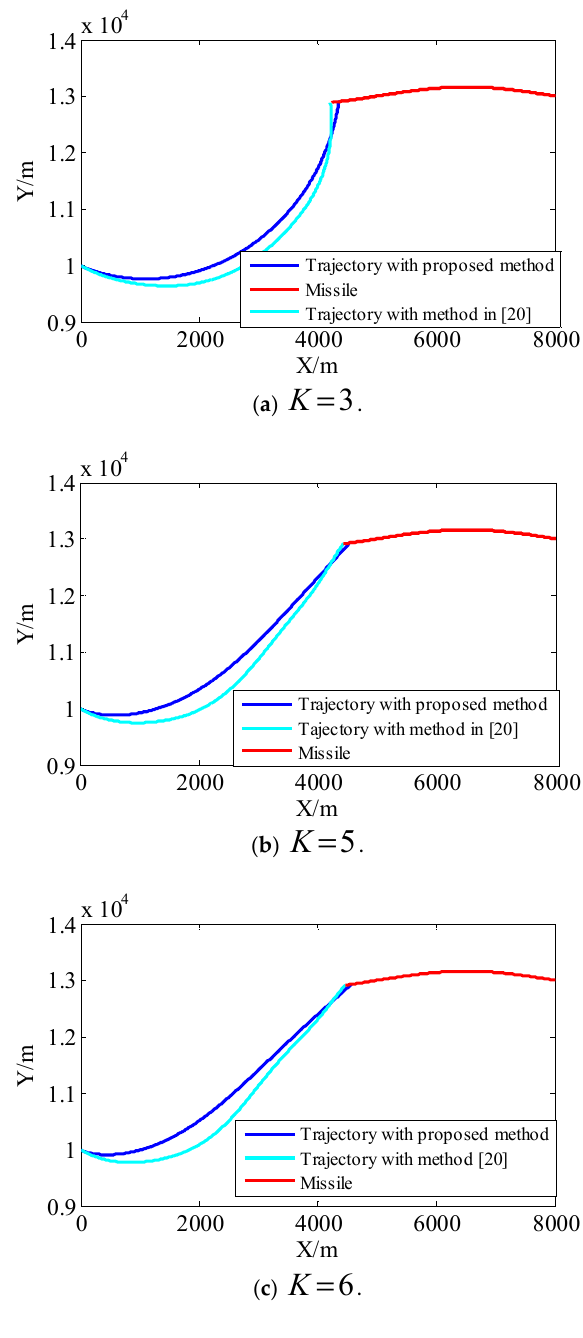
Figure 16. Contrast of trajectory with different guidance proportional coefficients.